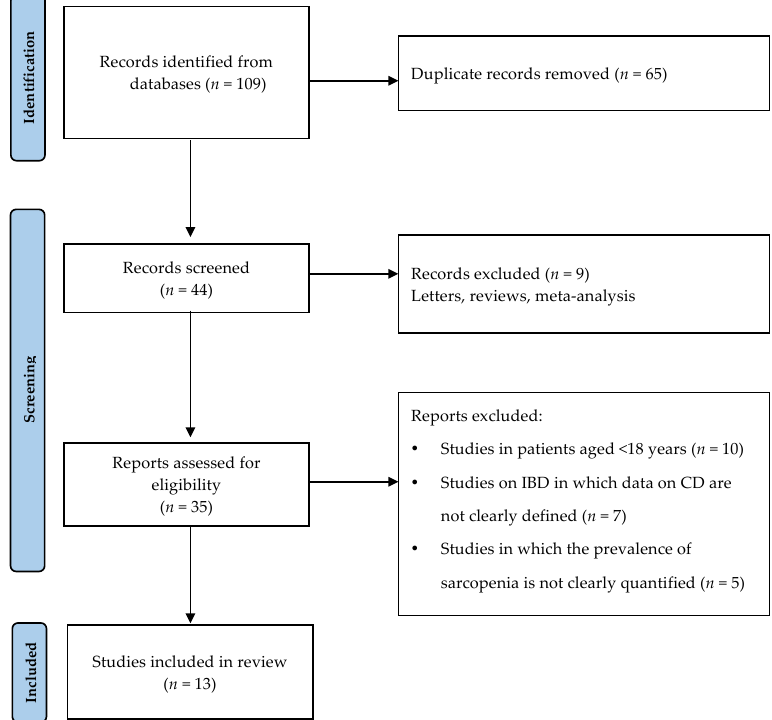
Figure 2. Flow diagram of the study selection process (adapted from PRISMA)